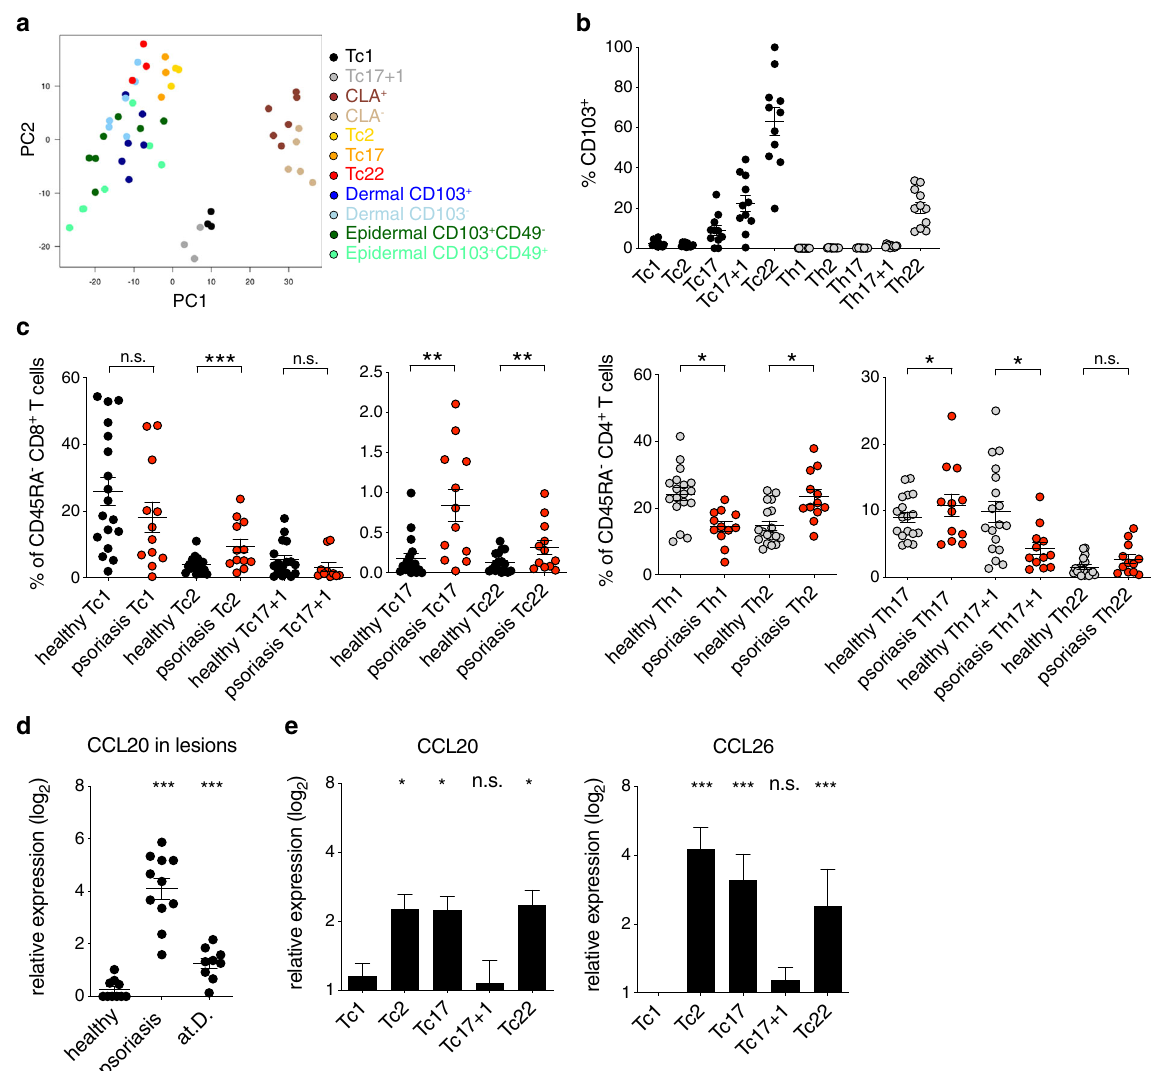
Fig. 4 Helper CD8 + memory T cells contribute to skin immunity. a PCA of CD8 + memory T-cell subsets and CLA + /CLA − blood-derived memory, CD103 + /CD103 − dermis derived, and CD49a + /CD49a − epidermis-derived CD8 + T cells of the GEO dataset GSE83637. b Frequencies of CD103 + T cells among indicated Tc- (black circles) and Th- (gray circles) cell subsets in human PBMCs. Mean± SEM. c Frequencies of peripheral Tc- (black circles) and Th- (gray circles) cell subsets of healthy donors or psoriasis patients (red circles). Mean ± SEM. Student ’ s t test. * P < 0.05, ** P < 0.01, *** P < 0.001. d mRNA levels of CCL20 in healthy skin, and lesions of psoriasis and atopic dermatitis (at.D.) patients relative to healthy control ( n = 10). Mean ± SEM. Student ’ s t test. * P < 0.05, ** P < 0.01, *** P < 0.001. e Relative expression of CCL20 and CCL26 by keratinocytes stimulated with supernatants derived from sorted and activated Tc-cell subsets ( n = 5). Mean ± SEM. Student ’ s t test. * P < 0.05, ** P < 0.01, *** P < 0.001 relative to